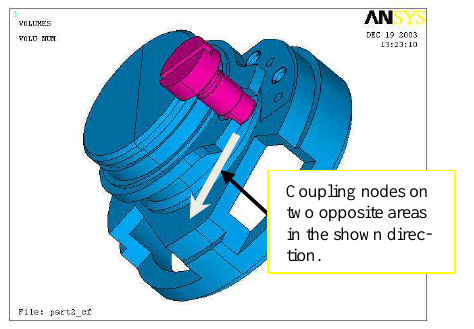
Fig. 8. Coupling between Internal Gear and